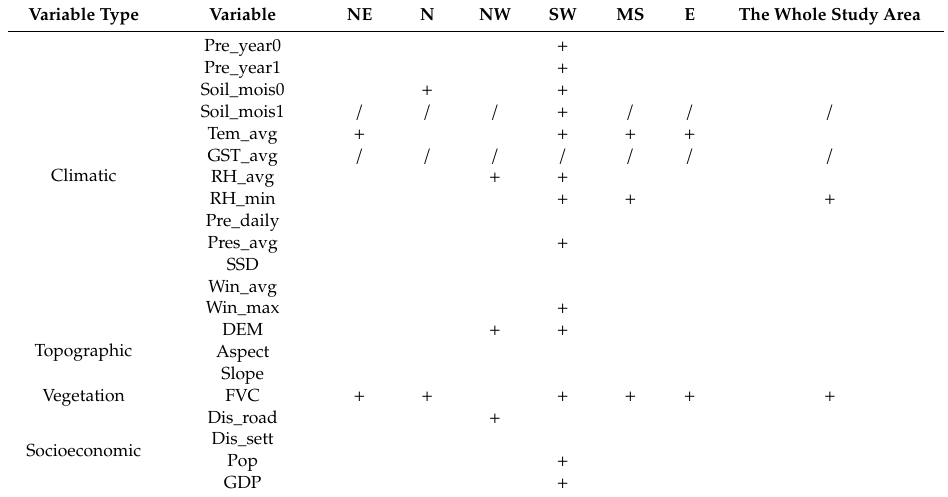
Table 4. The results when identifying the forest fire driving factors in six geographical regions and the whole study